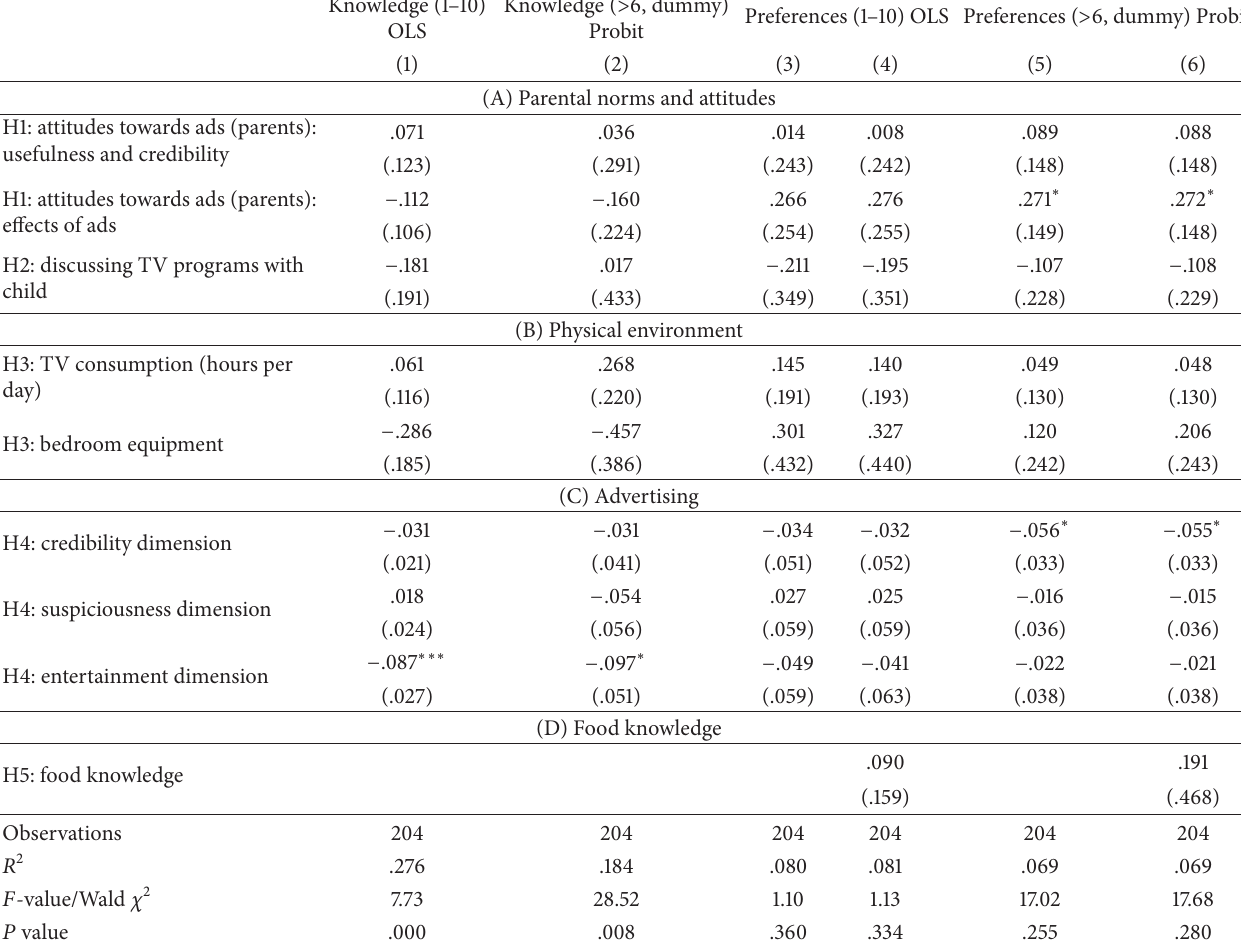
Table 2: Role of commercials on food knowledge and preferences: OLS/probit